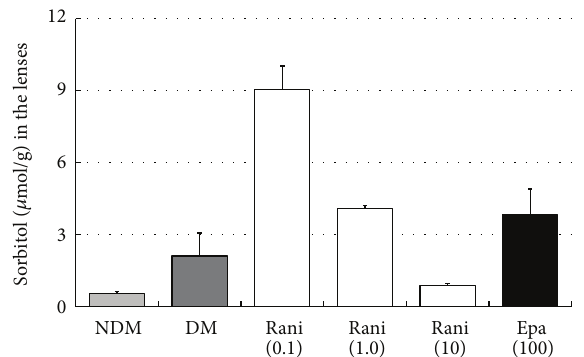
Figure 10: The fructose levels in the lenses at 40 weeks. The fructose level in the untreated lenses is very low compared with other ARI- treated lenses. NDM: non-diabetes mellitus; DM: diabetes mellitus; rani: ranirestat; epa: epalrestat.